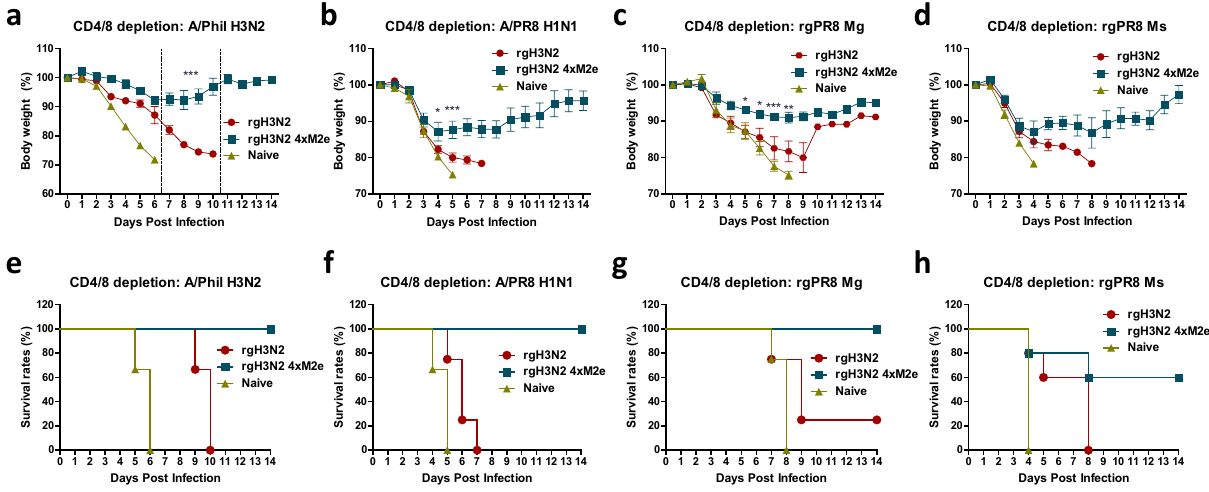
Figure 6. Depletion of CD4 and CD8 T cells results in differential cross protection between rgH3N2 and rgH3N2 4xM2e primed mice. The rgH3N2 or rgH3N2 4xM2e primed mice (n = 4 or 5/group) were treated with α-CD4/α-CD8 antibodies for T cell depletion prior to influenza virus infection. ( a – d ) Weight changes and ( e – h ) survival rates were monitored followed by A/Phil (H3N2) (17 LD 50 ), A/PR8 (1.5 LD 50 ), rgPR8 Mg (3 LD 50 ) and rgPR8 Ms (10 LD 50 ) challenge, respectively. Differential challenge doses were used depending on the subtype, pathogenicity, and T cell-depletion. Error bars indicate mean ± SEM. The statistical significances between rgH3N2 group versus rgH3N2 4xM2e group were determined using two-way ANOVA and indicated in *, P < 0.05; ***, P < 0.001.